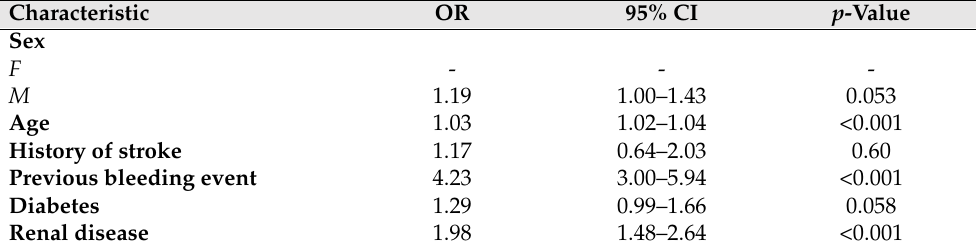
Table 5. Results from the logistic regression performed on risk of bleeding from 3867 patients treated with oral anticoagulant in primary care setting before their hospitalization. An OR > 1 was considered as a risk factor and a p -value < 0.05 was considered as significant. OR = Odds Ratio, CI = Confidence